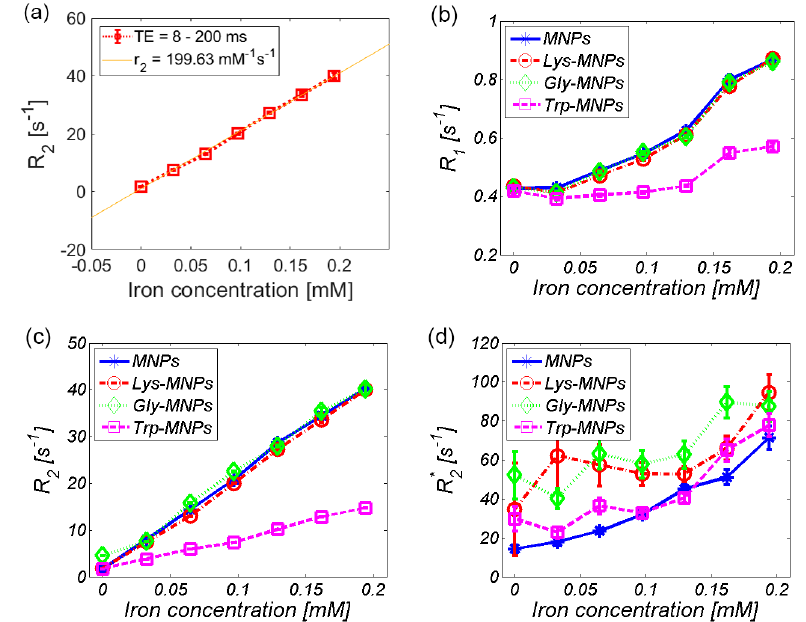
Figure 11. Relaxation rate of the AA–MNP complexes depending on iron concentration. ( a ) Linear fit of the transverse relaxation rate ( R 2 ) that determines the relaxivity value (r 2 ) of the Lys-MNP complex. Relaxation rates ( b ) R 1 , ( c ) R 2 , and ( d ) R 2* .